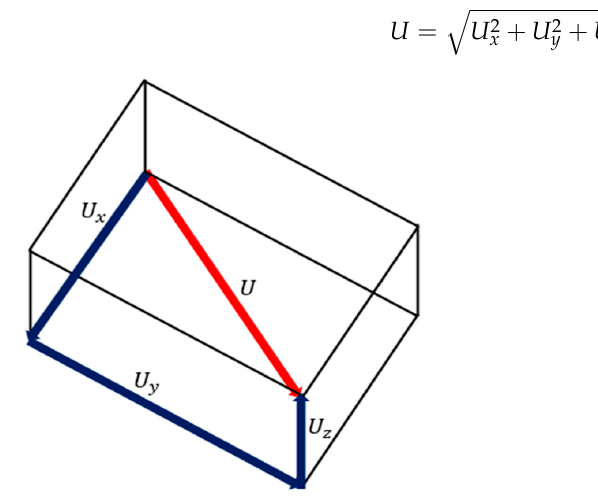
Figure 4. Calculation of the displacement vector for a symmetric model.